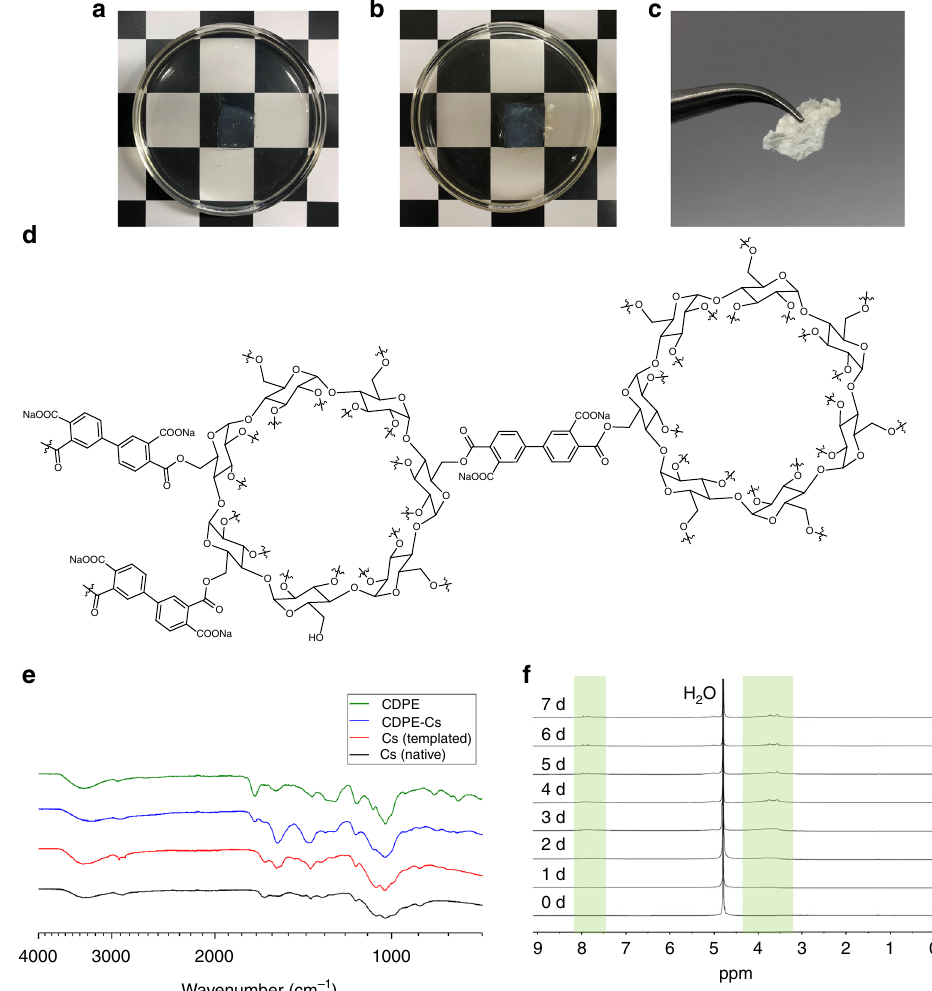
Fig. 1 CDPE hydrogels are capable of loading chitosan, and degrade in alkaline conditions. a Image of CDPE gel, upon initial immersion in a 1 wt% chitosan solution. b Image of CDPE gel, after 7 days immersion in a 1 wt% chitosan solution, showing a slight increase in opacity of the gel. c Image of templated chitosan monolith, after lyophilization of composite gel and rinsing with alkaline solution to remove the CDPE template. d Simpli fi ed representation of the chemical structure of CDPE, indicating the possibility of diverse linkage regiochemistry. e FTIR spectra of materials at each stage of the templating process. f 1 H NMR (500 MHz, in PBS D 2 O solution) spectra of the CDPE template at 24 h time points, showing degradation over 7